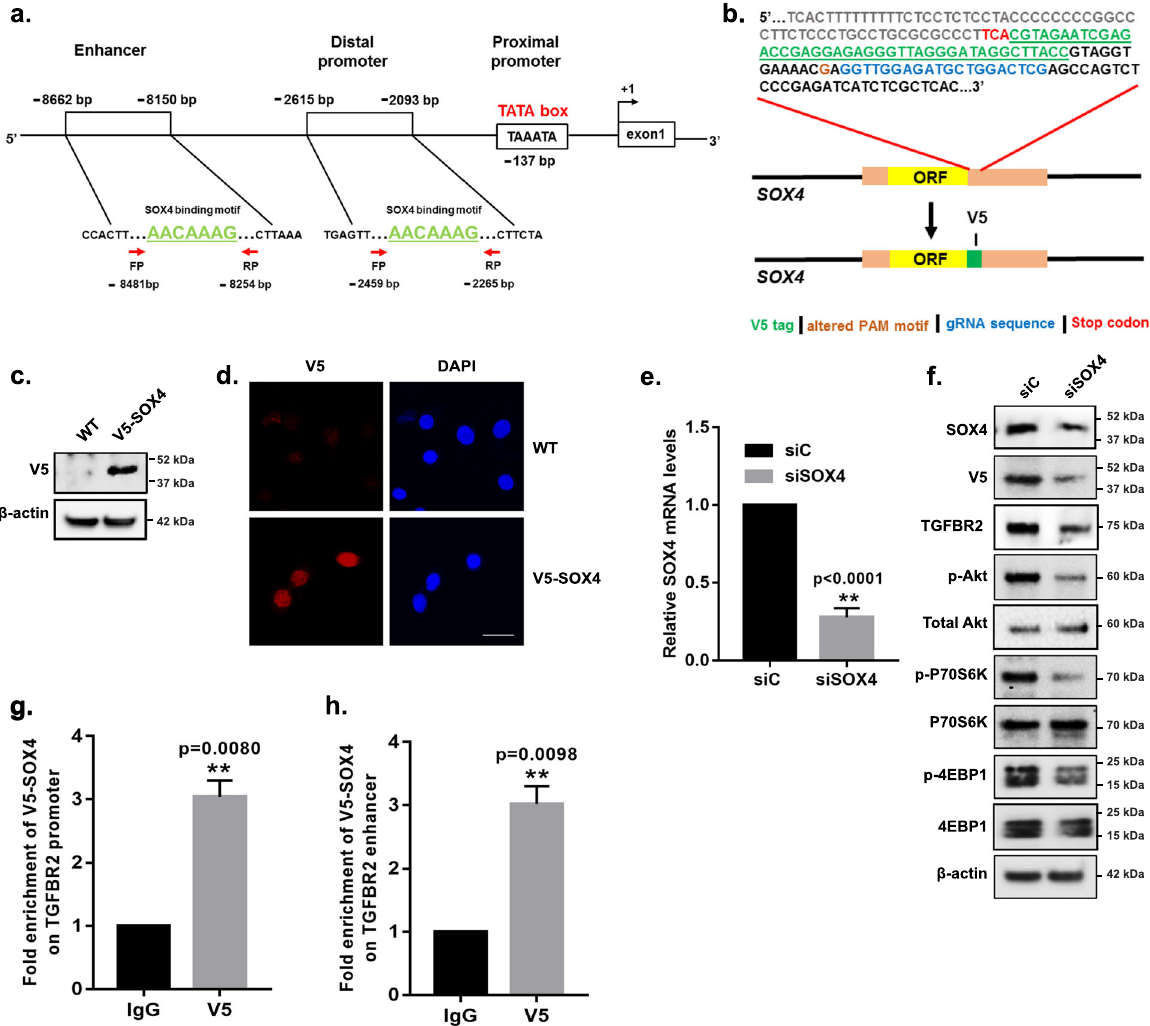
Fig. 4 SOX4 binds to regulatory sequences in TGFBR2 promoter and enhancer region. a Schematic representation of the TGFBR2 regulatory regions upstream from the transcription start site. The proximal promoter with TATA box (red), the SOX4 binding motif, (AACAAAG) in the distal promoter and enhancer (green), and forward/reverse primer locations (red arrows) are noted. b Schematic of the CRISPR/Cas9 genome editing strategy used to insert a C-terminal V5 epitope tag (green) at the 3 ′ locus immediately upstream of the stop codon (red); the gRNA sequence (blue) and the altered PAM motif (brown) are highlighted. c Western blot and d immuno fl uorescence demonstrate V5 expression in the HCC1143 SOX4-V5 cell line; no expression is observed in the parental cell. The scale bar is 100 µm. e qRT-PCR demonstrates that SOX4 mRNA levels are signi fi cantly reduced by siSOX4 in HCC1143 SOX4-V5 ( p < 0.0001) relative to siControl transfected cells (50 nm, 96 h). f Western blot analyses demonstrated reduced protein expression of SOX4, V5, TGFBR2, and phosphorylated PI3K pathway marker proteins in HCC1143 SOX4-V5 cells transfected with siSOX4 relative to siControl-treated cells (96 h). g ChIP-qPCR using anti-V5 antibody demonstrated a 3.03-fold enrichment ( p = 0.008, unpaired t -test) of V5-tagged Sox4 protein at the TGFBR2 promoter relative to IgG control. h A 3.01-fold enrichment of V5 protein ( p = 0.01, unpaired t -test) was observed at the TGFBR2 enhancer in HCC1143 SOX4-V5 cells relative to IgG control. Fold enrichment is normalized to PNOC promoter region, which is used as a negative